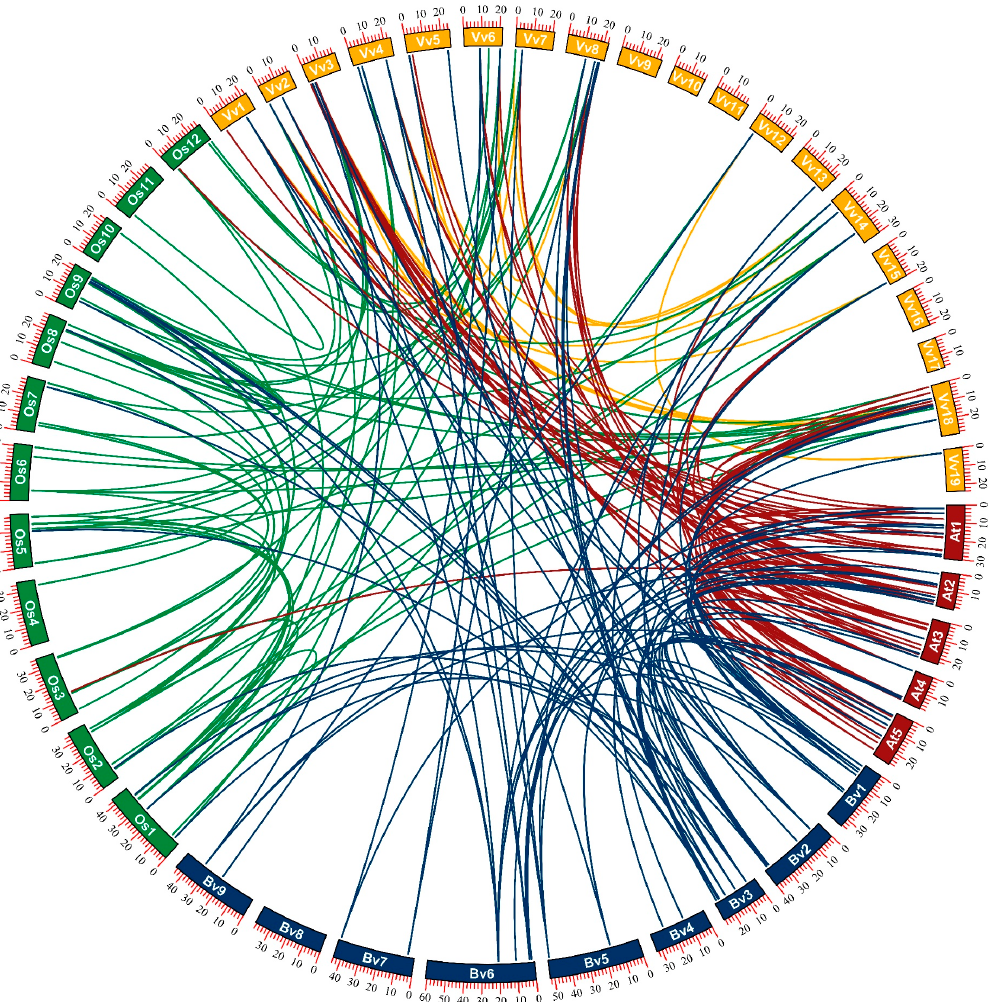
Figure 4. Collinearity analysis of bZIP genes in sugar beet, Arabidopsis, rice and grape. Blue for sugar beets, red for Arabidopsis, green for rice and purple for grapes. The lines link bZIP genes that were linked by fragment replication between different species.